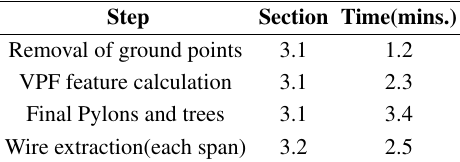
Table 4. Running time for different steps of the proposed